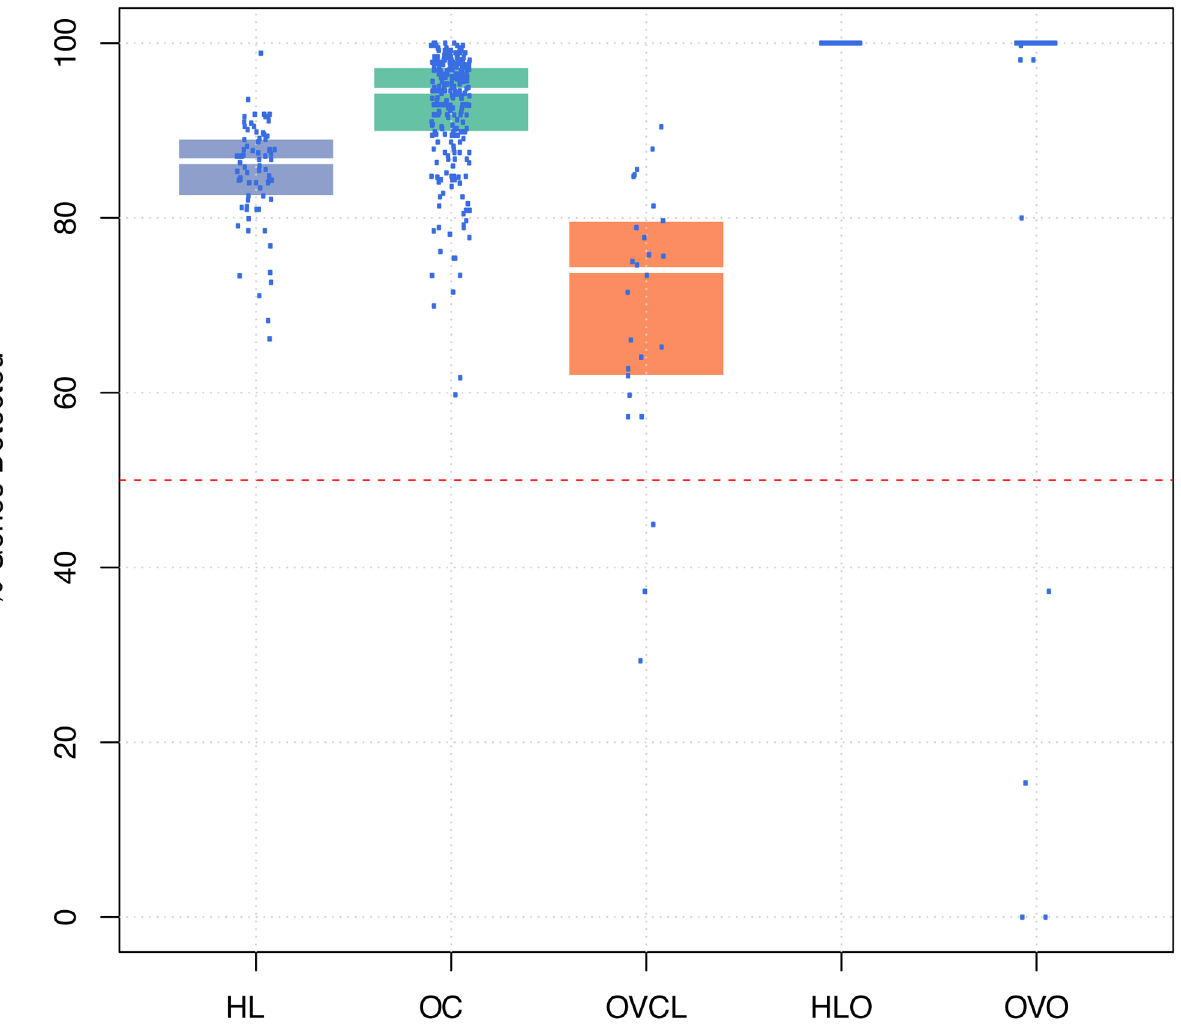
Fig 1. Percentage of genes detected above the limit of detection (LOD) by cohort. Each point on the boxplot represents a NanoString nCounter unique run (duplicates and triplicates included where available). The colored boxes represent the distribution of the percentage of genes detected in a particular cohort. The white line indicates the median. A cutoff of 50% was used for Cell Lines and clinical samples, and 95% was used for oligonucleotide samples. HL: Hodgkin lymphoma clinical samples, OC: ovarian cancer clinical samples, OVCL: ovarian cancer cell lines, HLO: oligonucleotides corresponding to the HL CodeSet, OVO: oligonucleotides corresponding to the OC